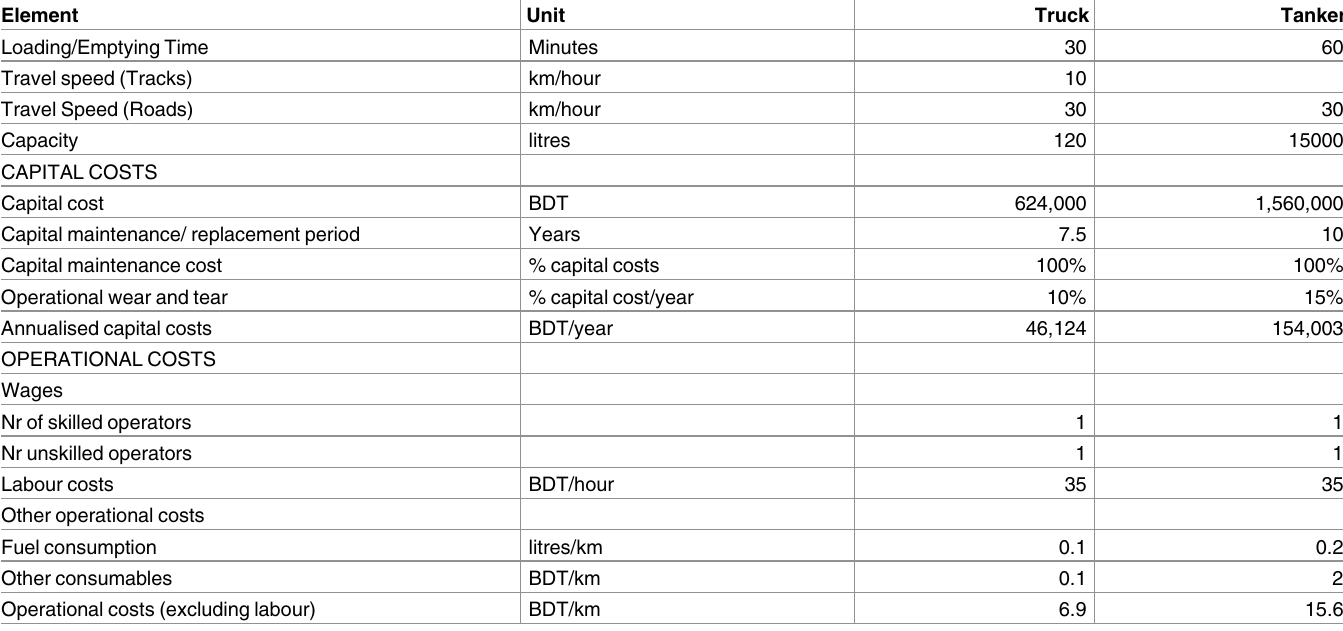
Table 5. Performancecharacteristics-transport